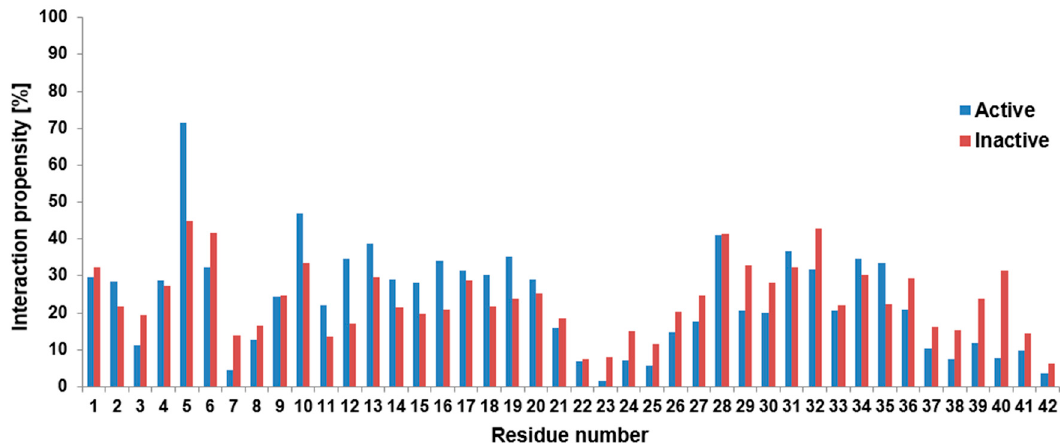
Figure 3. Interaction propensity per residue according to the close contact of the fluorophore part of the dye and the concerned